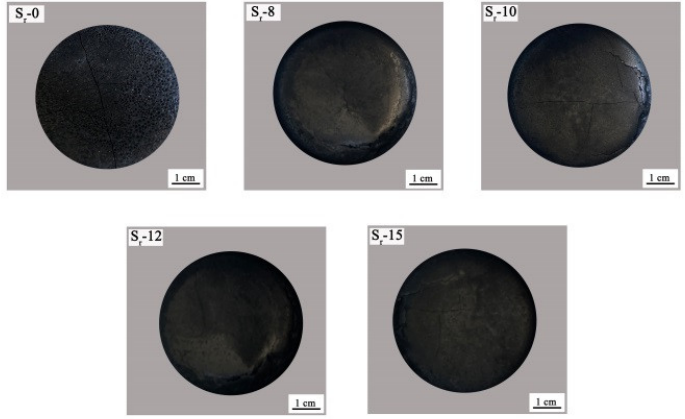
Figure 1. Roasted blast furnace tempered slag